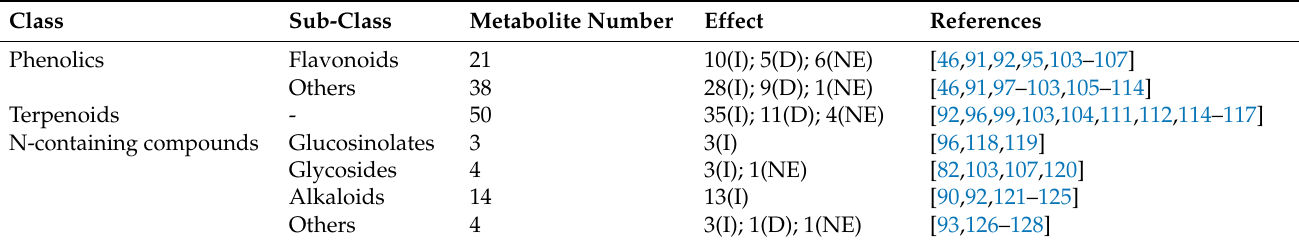
Table 3. Effects of drought stress on plant secondary